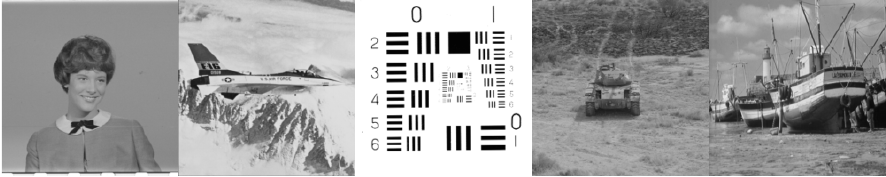
Figure 6. Thumbnails of USC-SIPI.